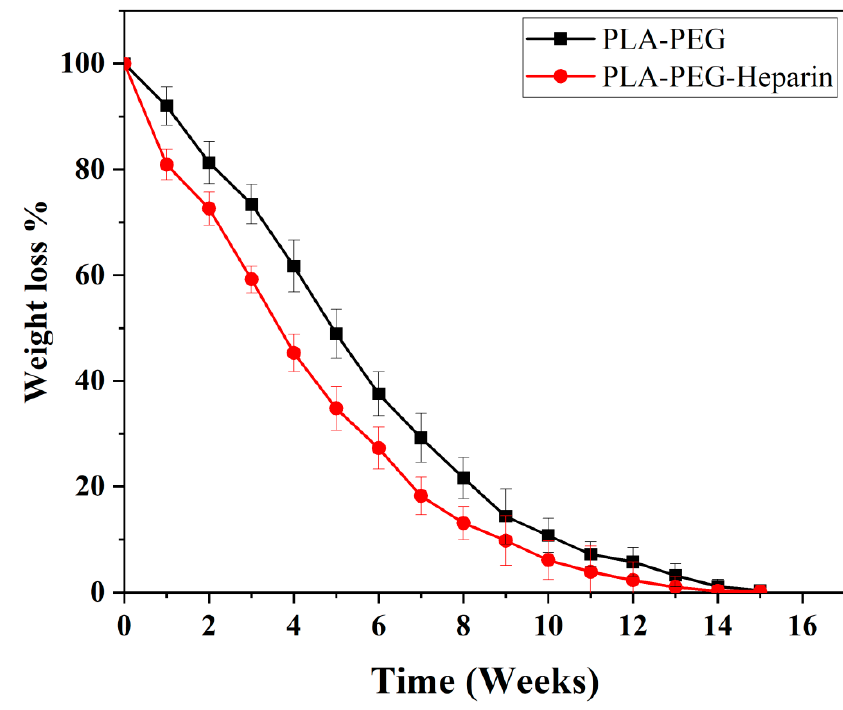
Figure 15. In vitro degradation profile of PLA-PEG and PLA-PEG-heparin copolymer.